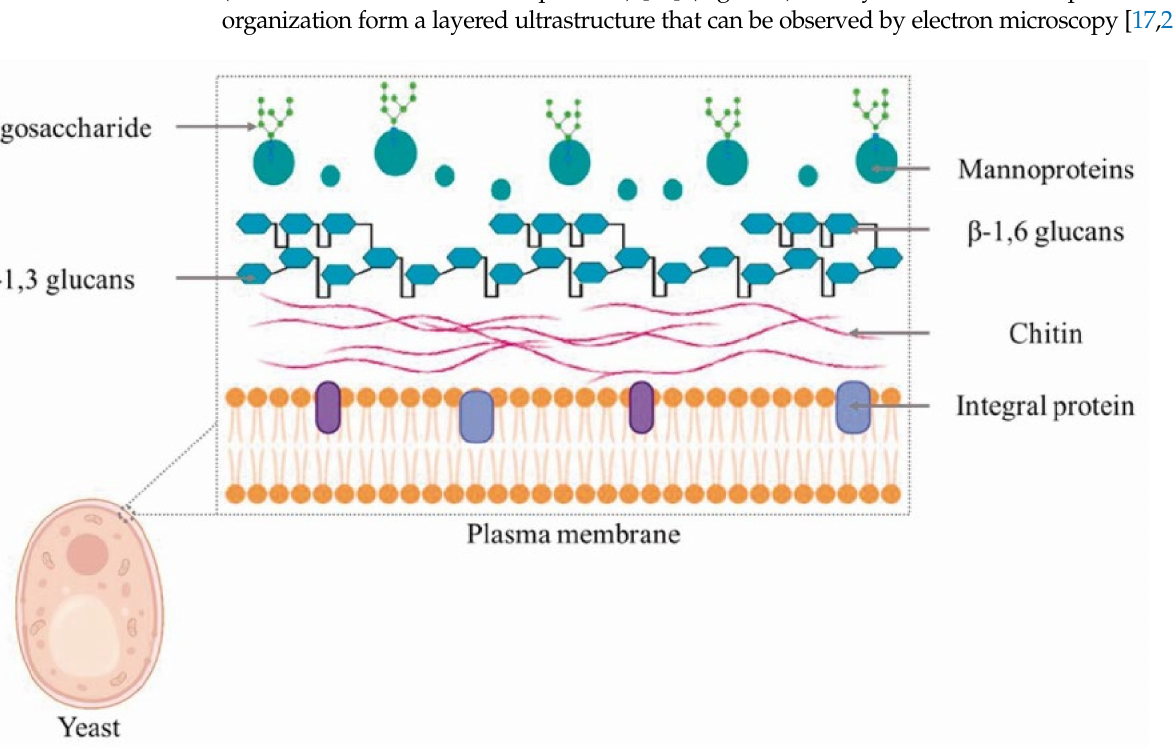
Figure 1. Conformation of the yeast cell wall. The cell wall is the largest, most resistant, and rigid organelle affecting the interaction with the external environment and the protection of the intracellular organelles, where compounds of great biotechnological interest are found including β